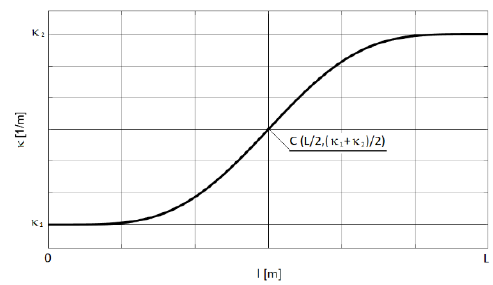
Figure 1. The exemplary κ(l) function symmetrical towards the point C(L/2, (κ 1 + κ 2 )/2).